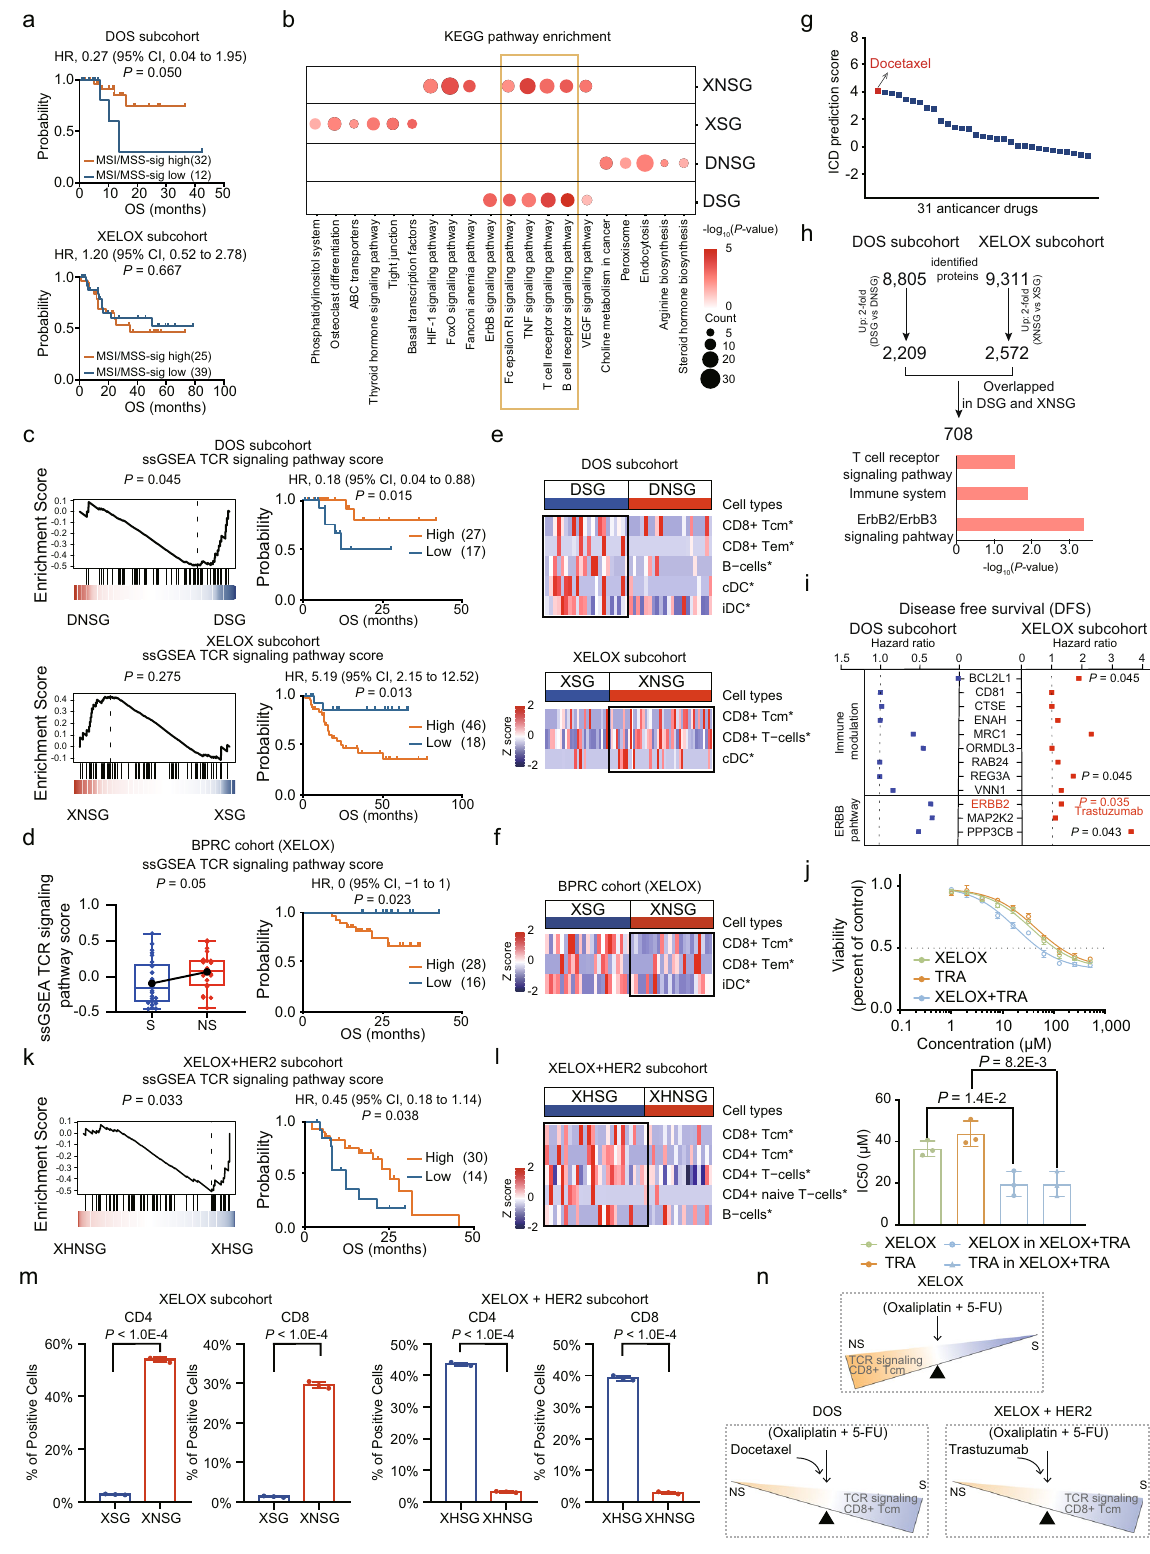
(Supplementary Fig. 5g). Moreover, XHSG had signi fi cantly increased percentage of CD4 positive cells(43.7%) and CD8 positive cells (39.2%) than XHNSG (3.2% and 2.9%, respectively) ( P < 1E − 4); while the per- centage of CD4 positive cells and CD8 positive cells were higher in XNSG (54.2% and 29.7%, respectively) compared with XSG (2.9% and 1.4%, respectively) ( P <0.05) (Fig. 4m).The result veri fi ed the fi ndings